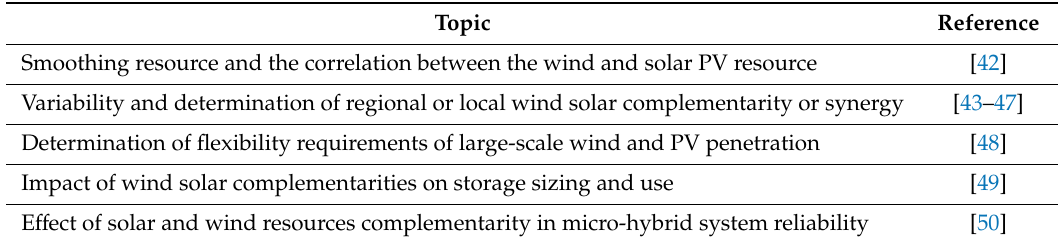
Table 1. Literature review reference